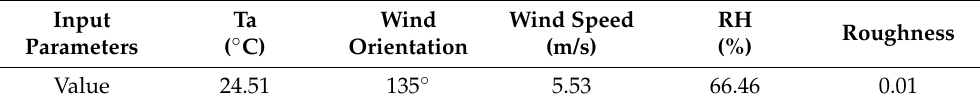
Table 2. Initial input values of weather parameters for the simulation model.